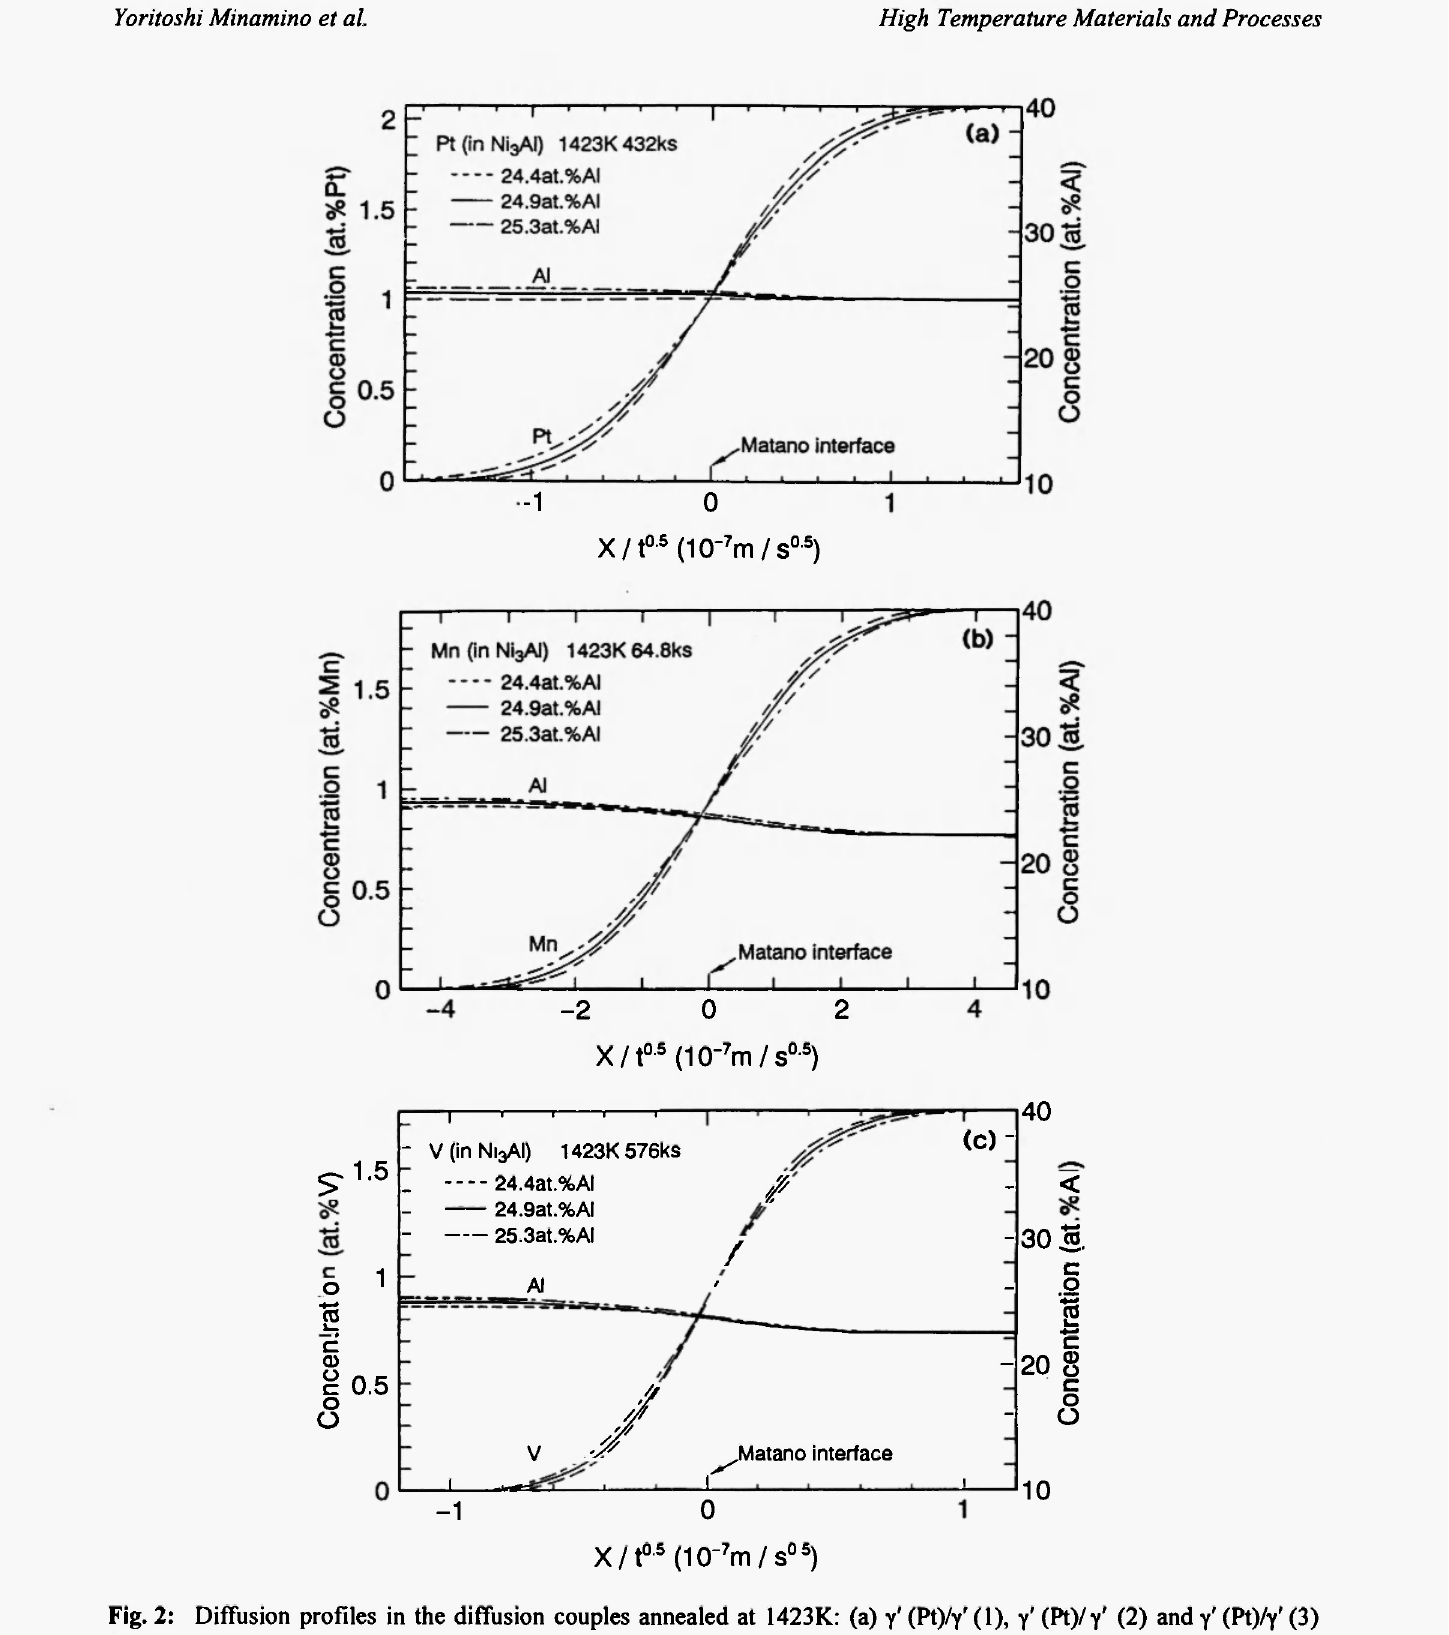
Fig. 2: Diffusion profiles in the diffusion couples annealed at 1423K: (a) γ' (Pt)/y' (1), γ' (Pt)/Y (2) and γ' (Pt)V (3) couples, (b) γ' (Μη)/γ' (1), γ' (Μη)/γ' (2) and γ' (Μη)/γ' (3) couples, and (c) γ' (V)/ V ' (1), γ' (V)V (2) and γ' (V)/ Y ' (3)